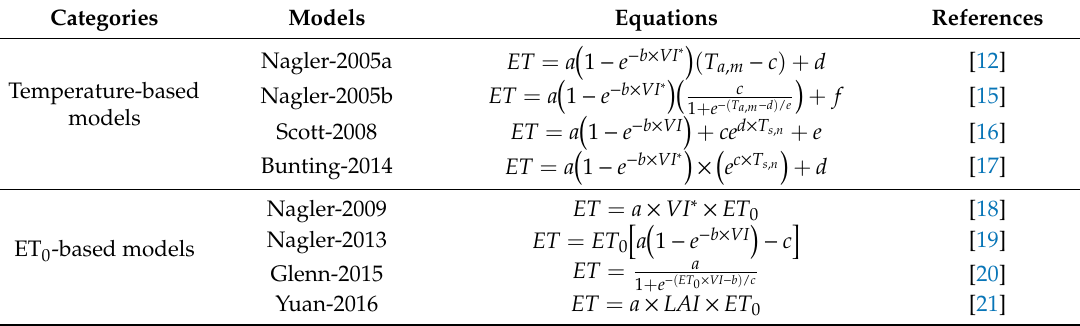
Table 1. ERSETMs constructed for ET estimation in arid and semiarid